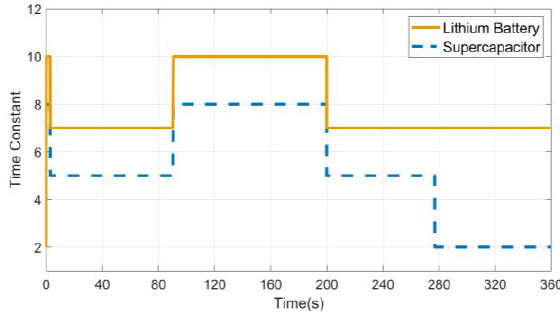
Figure 19. Variation in filter time constants for energy storage devices.